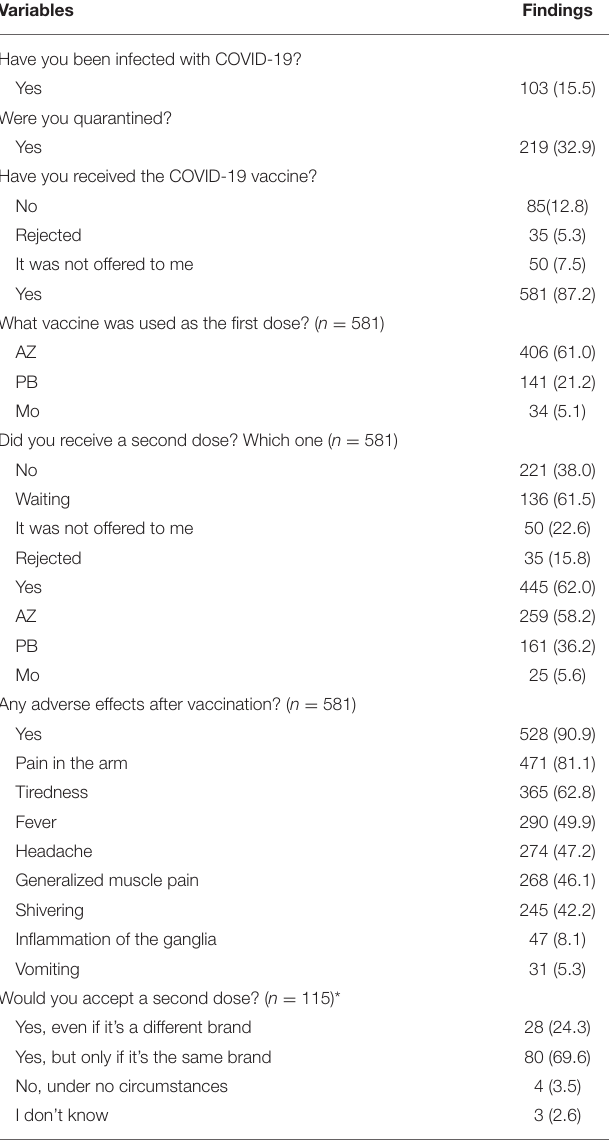
TABLE 3 | Impact of COVID-19, vaccine acceptance and adverse effects of vaccination. Variables